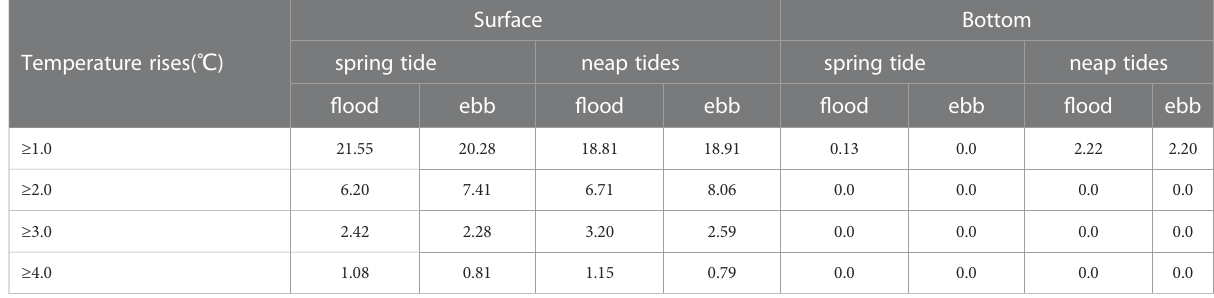
TABLE 1 Statistics of model simulated surface and bottom temperature rise area (Unit: km 2 ) during spring and neap tide periods due to the cooling water discharge from the Daya Bay Nuclear Power Plant (DBNPP) in summer.